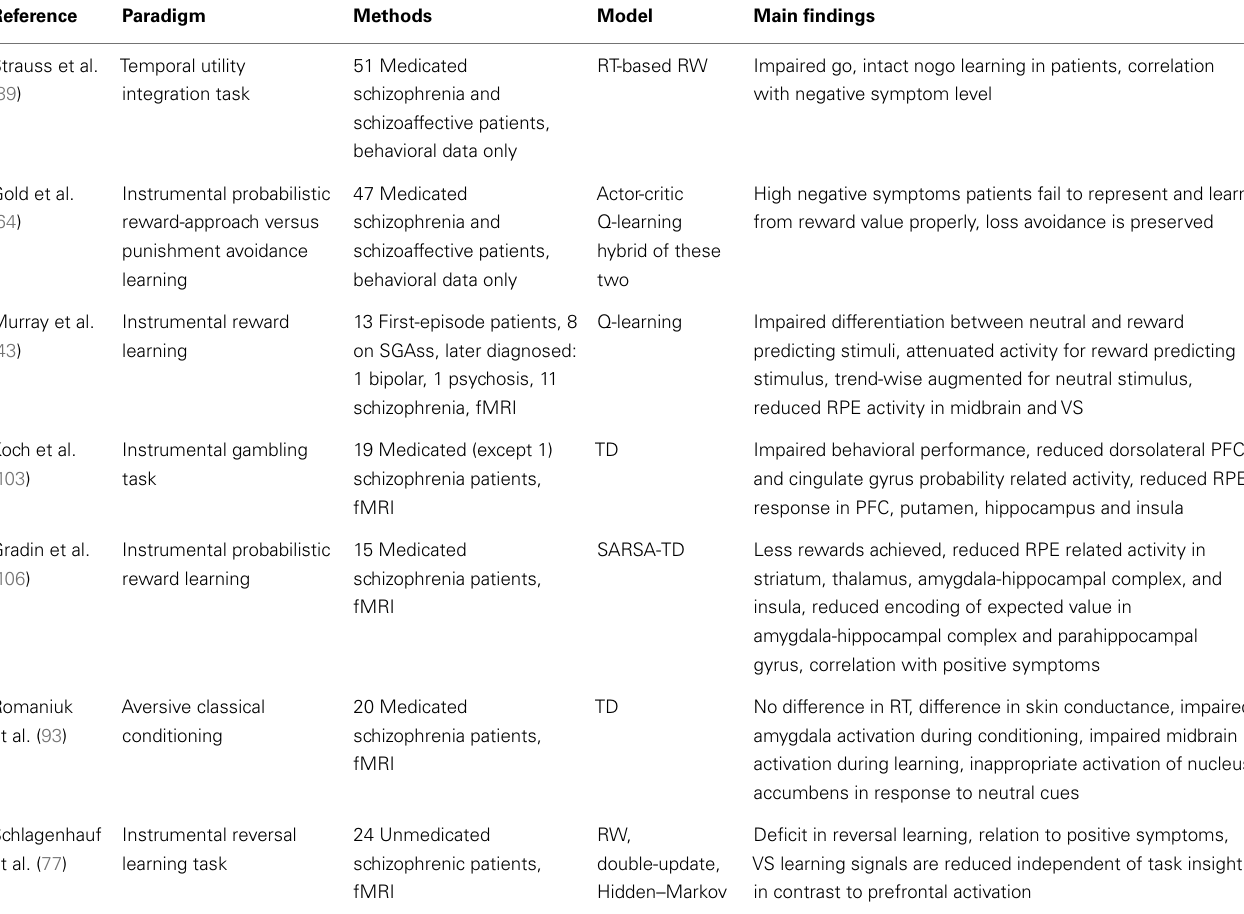
Table 1 | Studies in schizophrenia patients using a computational model